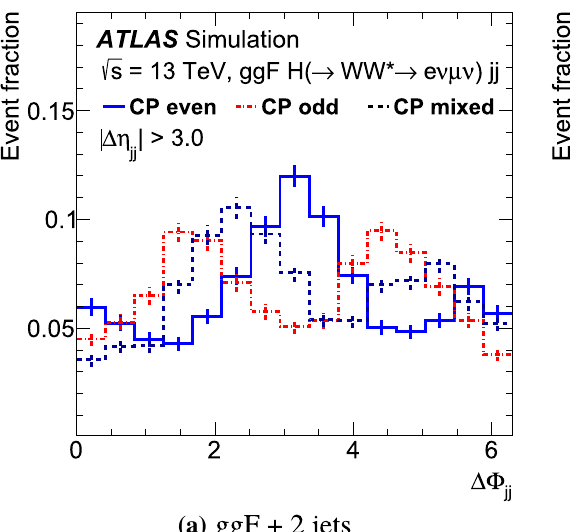
eters in VBF events. These comparisons are performed at the generator level using the predictions of the MadGraph5 _aMC@NLO 2.4.2 + Pythia 8.212 [32]